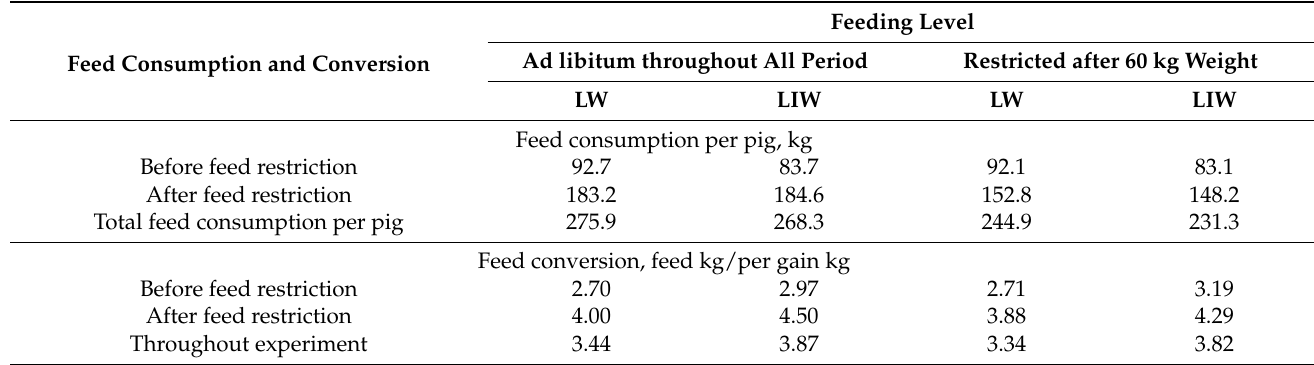
Table 1. Average feed consumption and conversion per pig by